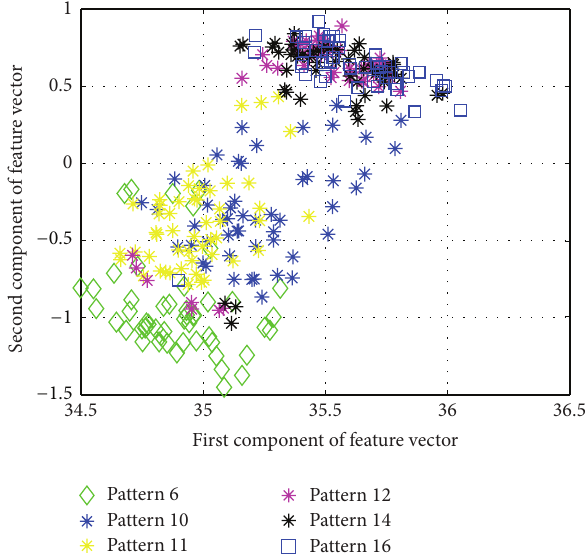
Figure 15: The DFT feature vectors of data patterns in second scenario from sensor node